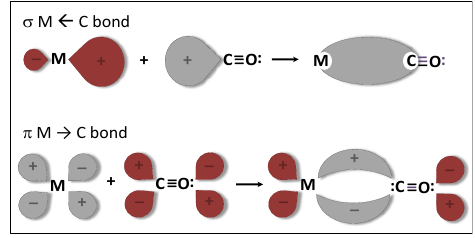
Figure 3. Metal atomic (M) orbitals and CO molecular orbitals involved in the adsorption.